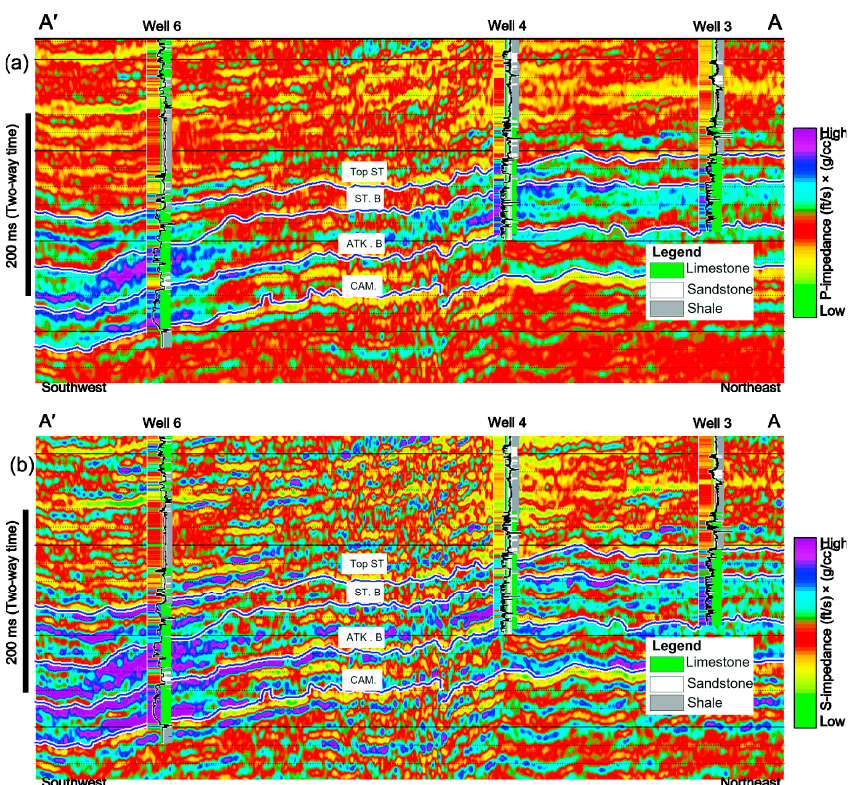
Figure 8. Cross section A–A ′ of inverted ( a ) P-impedance and ( b ) S-impedance volumes passing through wells 3, 4, and 6. Note: inserted color log at well locations = actual impedance, black curve = gamma-ray log, and inserted litholog = limestone (green), sandstone (white), and shale (gray) composition. Top ST—top Strawn, ST. B—Strawn B, ATK. B—Atoka Base, and CAM.—Cambrian.